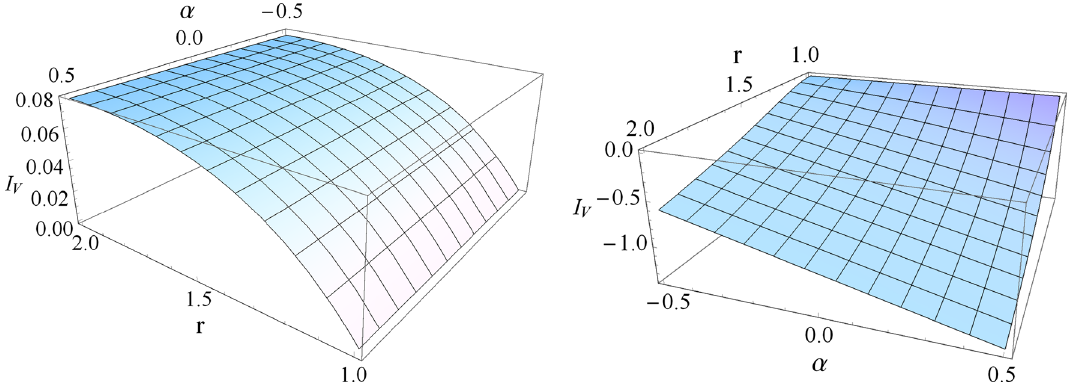
Fig. 9 3D plots for ‘volume-integral quantifier’ associate with model A & B in Sect. 3. Interesting to find that when a → r + minimize the violation of energy conditions would be possible. We consider the same set of values as of Figs. 1 and 2 with a = 2